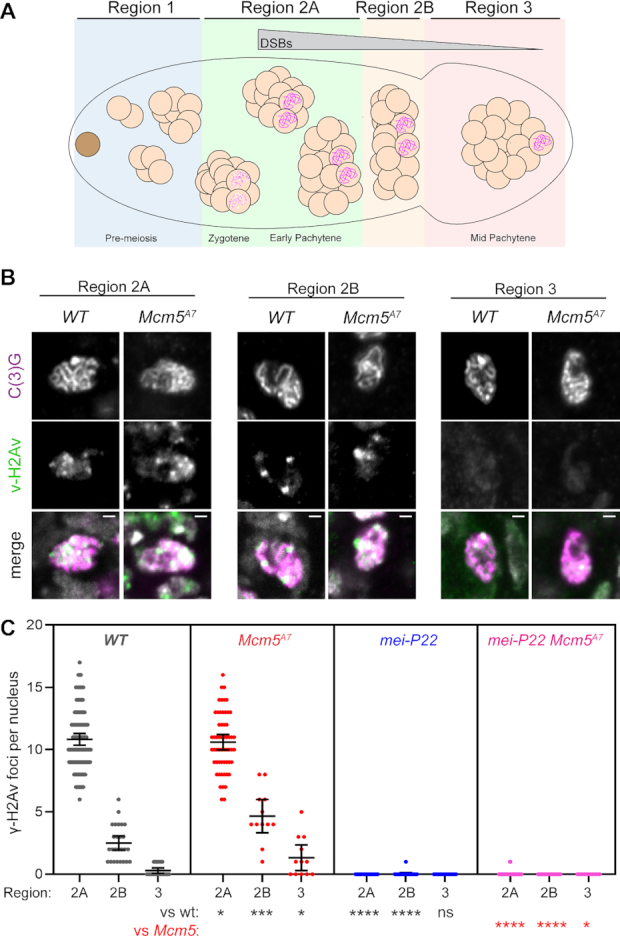
Meiotic double-strand breaks are repaired with normal kinetics in Mcm5A7. (A) Schematic of the Drosophila germarium. The germline stem cell (brown), cystoblast (not shown), and developing 2-, 4- and 8-cell cystocytes (cc) reside in the pre-meiotic mitotic region of the germarium, Region 1. Meiotic onset occurs within the most anterior 16-cc in Region 2A, which is cytologically defined as zygotene. In early pachytene (Region 2A), formation of the synaptonemal complex (SC, pink scribble) is complete and meiotic double-strand break (DSB) formation begins. Meiotic DSBs are repaired as the 16-cc progresses through early pachytene (Region 2B) and into mid-pachytene (Region 3). (B) Representative images of γ-H2Av foci (green) in WT and Mcm5A7meiotic nuclei (as defined by the present of the SC component, C(3)G, pink) within Regions 2A, 2B, and 3. Merge images include DAPI in gray. Image brightness and contrast have been adjusted for clarity. Bright puncta in merged images are DAPI-dense chromocenters. (C) Quantification of γ-H2Av foci. Each dot represents one nucleus; bars show mean and 95% confidence intervals. Results of unpaired t-tests compared to wild type (black) and to Mcm5A7 (red) are indicated below. ns, P > 0.05; *P < 0.05, **P < 0.01, ***P < 0.001, ****P < 0.0001. n = (across the three regions) for WT: 99, 25, 18; for Mcm5A7: 48, 10, 10; for mei-P22: 60, 19, 11; for mei-P22 Mcm5A7: 68, 19, 11.